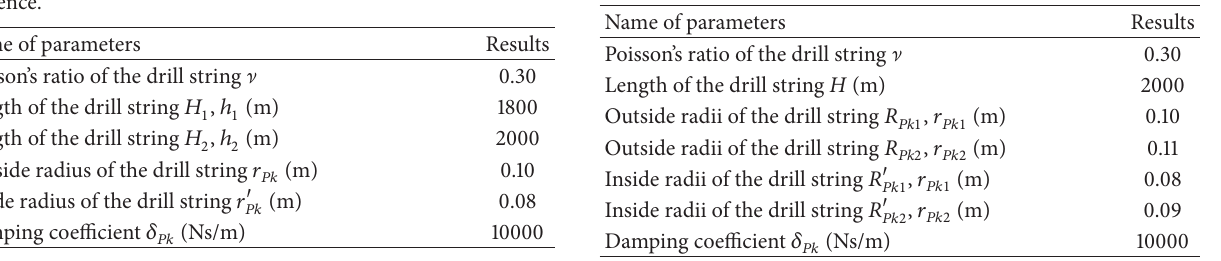
Figure 3: Influence of outside radius on dynamic stiffness. Table 3: Calculated parameters of the inside and outside radius